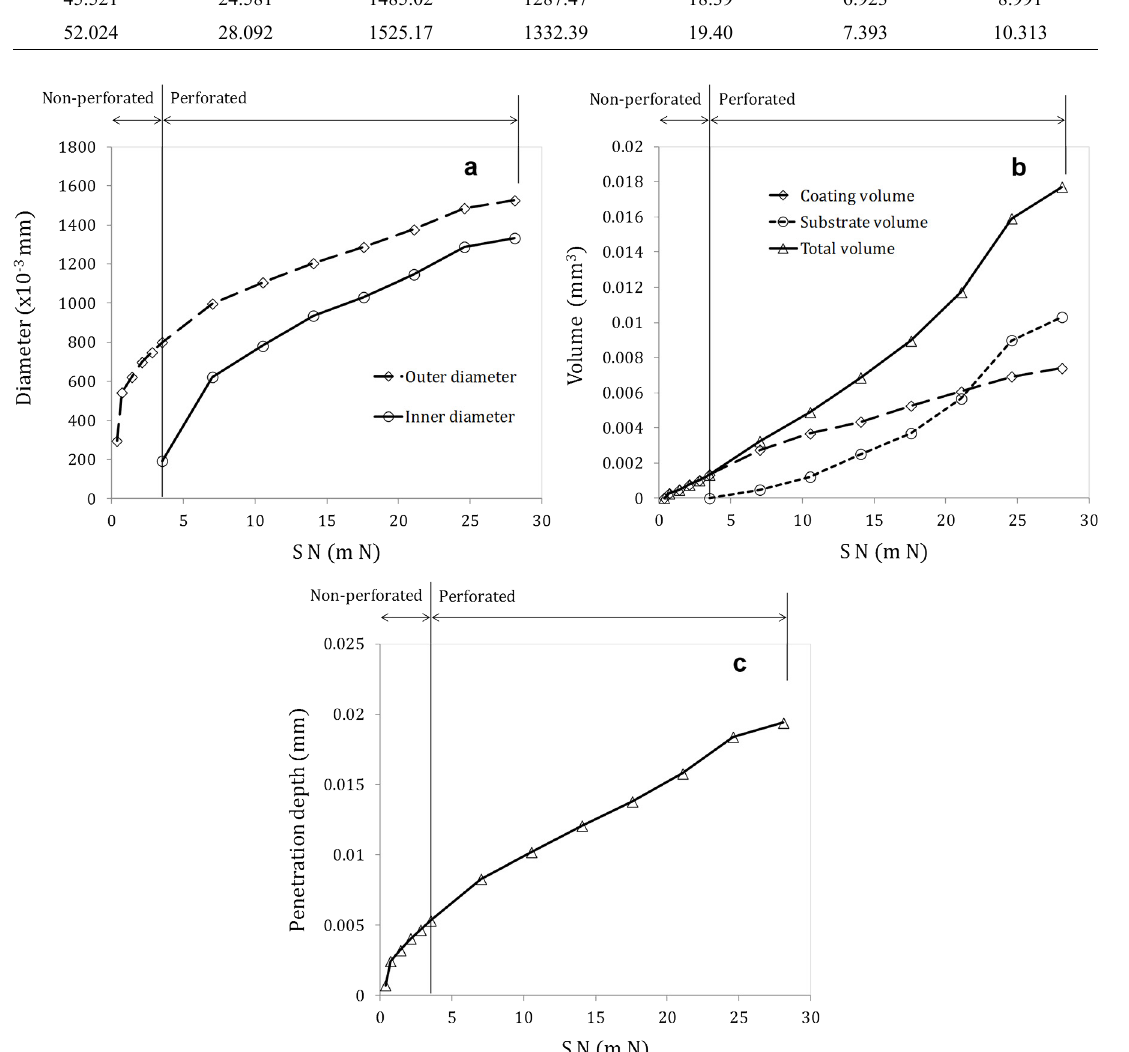
Figure 11. Plots of SN versus: (a) diameter, (b) volume and (c) penetration